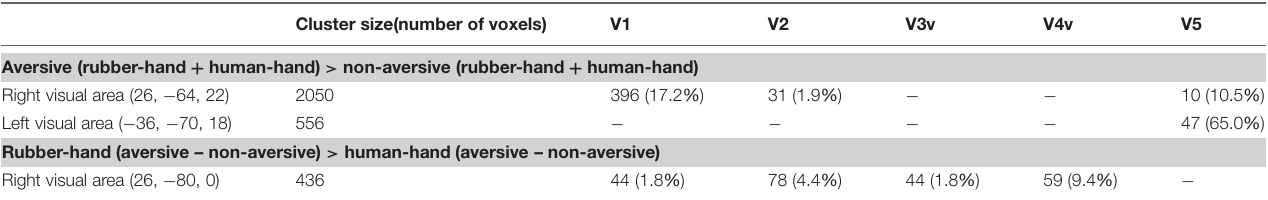
TABLE 3 | Classifications of the visual areas (V1, V2, V3v, V4, and V5) in three clusters. Cluster size(number of voxels) V1 V2 V3v V4v V5